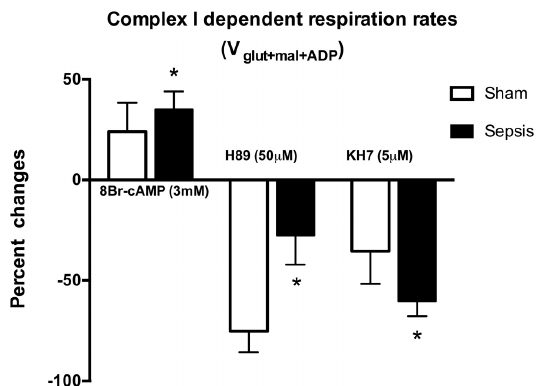
Figure 4. Changes of mitochondrial complex I-dependent “state 3” (V glut+mal+ADP ) respiration rates in sham and sepsis (cecal ligation and puncture (CLP)) in permeabilized cardiac fibers in response to 8Br-cAMP; H89; or KH7. See Materials and Methods for details. Data are expressed as percent of change and displayed as mean ± SD. Results were analyzed with one-way ANOVA and Bonferroni’s multiple comparison post hoc adjustment ( n = 8 in each group; * indicates adjusted p < 0.01 versus sham).